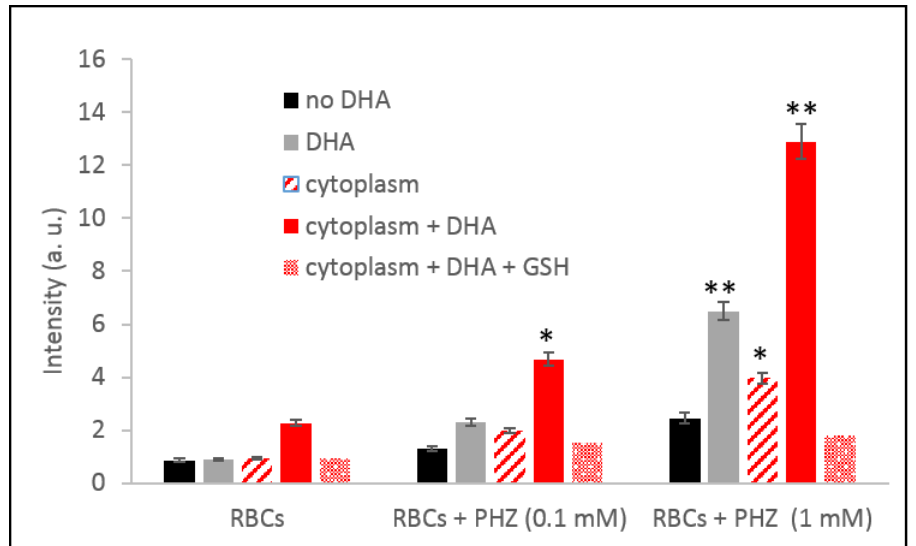
Figure 6. Production of ROS measured by EPR in PHZ-treated and untreated RBC in the presence of their respective cytoplasm enriched with NADPH (nicotinamide adenine dinucleotide phosphate) or GSH 3 mM. Data are the average ± SD of 5 independent experiments. Significant differences to untreated RBCs at * p < 0.05; ** p < 0.001.